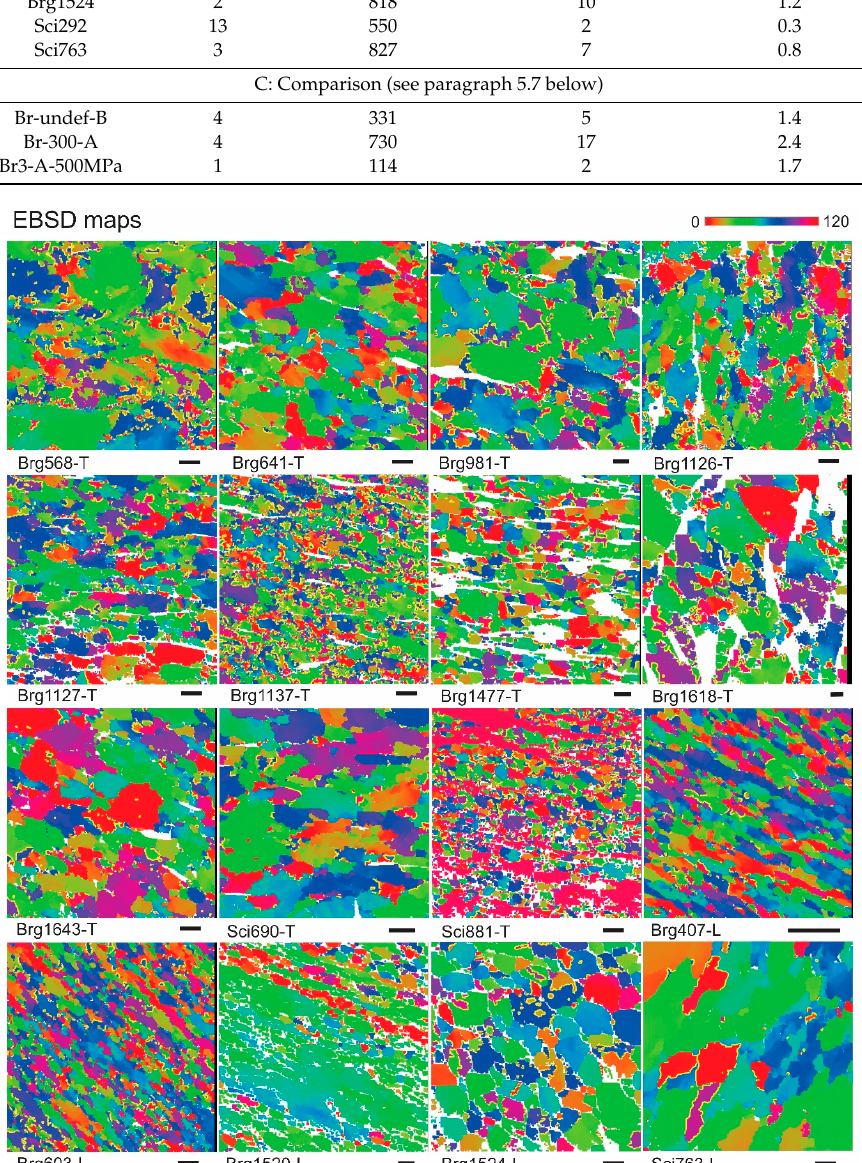
Figure 11. Selected EBSD maps with Dauphiné twin boundaries (yellow). Colors shown on top right are based on Euler angle φ 2 that is sensitive to twinning. T is for Triassic quartzites and L is for quartz layers. White are regions that could not be indexed and correspond mainly to muscovite. Scale bars are 100 µm. 100 µ